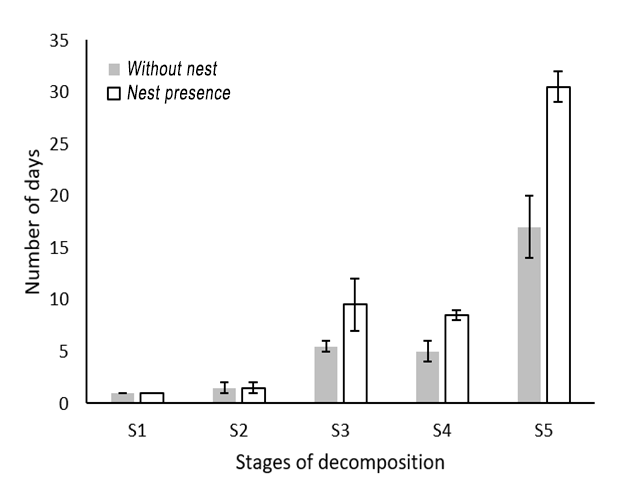
Fig 1 - Average duration (number of days) of decomposition phases for domestic pig carcasses with and without exposure to Solenopsis saevissima nest in an urban Amazon forest remnant in São Luís, Maranhão, Brazil. S1: Fresh; S2: Bloated; S3: Active decay; S4: Advanced decay; S5: Dry and